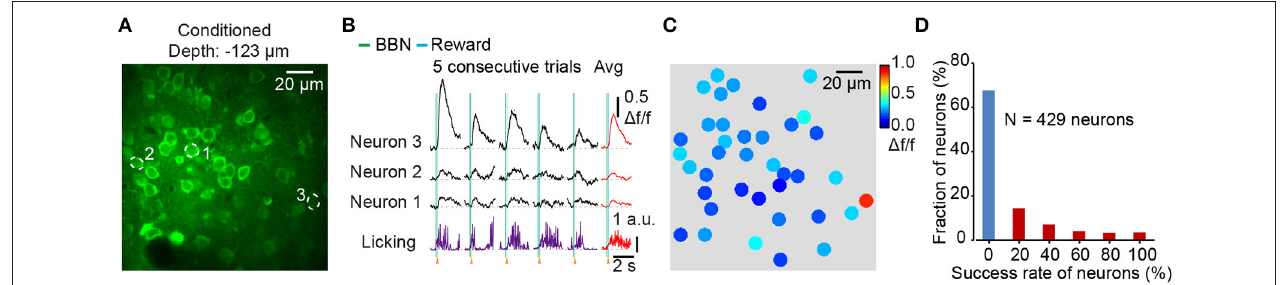
FIGURE 3 | Figure 3 . Population imaging in the Au1 of conditioned mice during behavior . (A) Average image (400 frames) of a focal plane in layer 2/3 of the Au1. (B) Ca 2 + transients and corresponding licking responses from 5 consecutive trials. Neurons are outlined by dotted circles in A . (C) Color mapping of the average 1 f/f of 3 consecutive Ca 2 + transients evoked by BBN for each neuron in A . (D) The fraction of success rate for all neurons in 5 consecutive trials. 429 neurons from 7 conditioned mice.